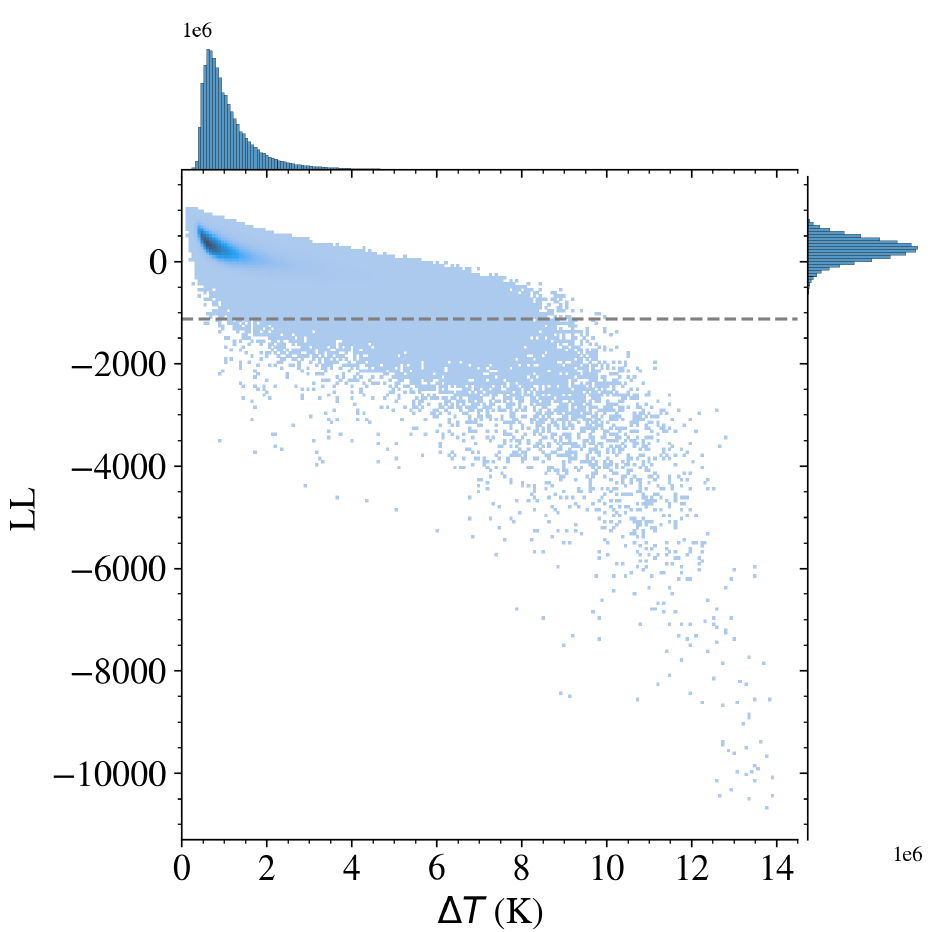
Figure 10. Distribution of LL values as a function of ∆ T . While there is a strong anti-correlation, the relationship exhibits substantial scatter such that ∆ T is not a precise predictor of LL nor the underlying SSTa patterns characterized by ULMO . The horizontal line at LL ≈ − 1123 corresponds to the 0.1% threshold; cutouts with log-likelihood values beneath this line are considered to be